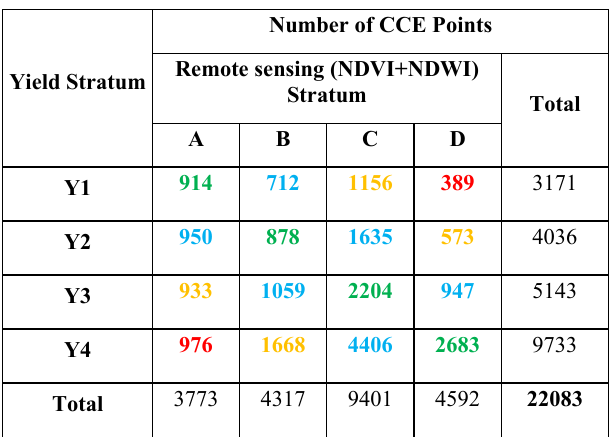
Figure 2: Stratum wise CCE distribution in Odisha in 2016-17 It was found that, in 2016-17, in 30% cases the CCE yield stratum was exactly matching with the VUI stratum. In 44% cases, it was only one category difference. 2 and 3 category difference were found in 20 and 60 per cent, cases, respectively. Thus 74 % (30+44) yield values were matching with VI strata within one category difference. The points which have more than 2 category difference were considered as outliers, which needed further checking.